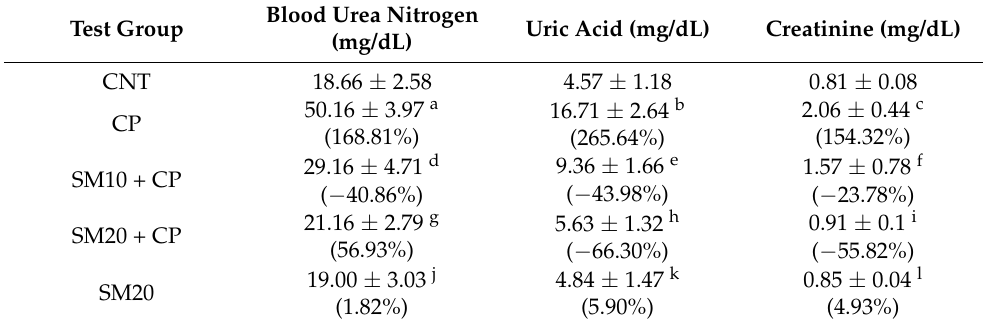
Table 1. Effect of SM on serum markers against CP-induced